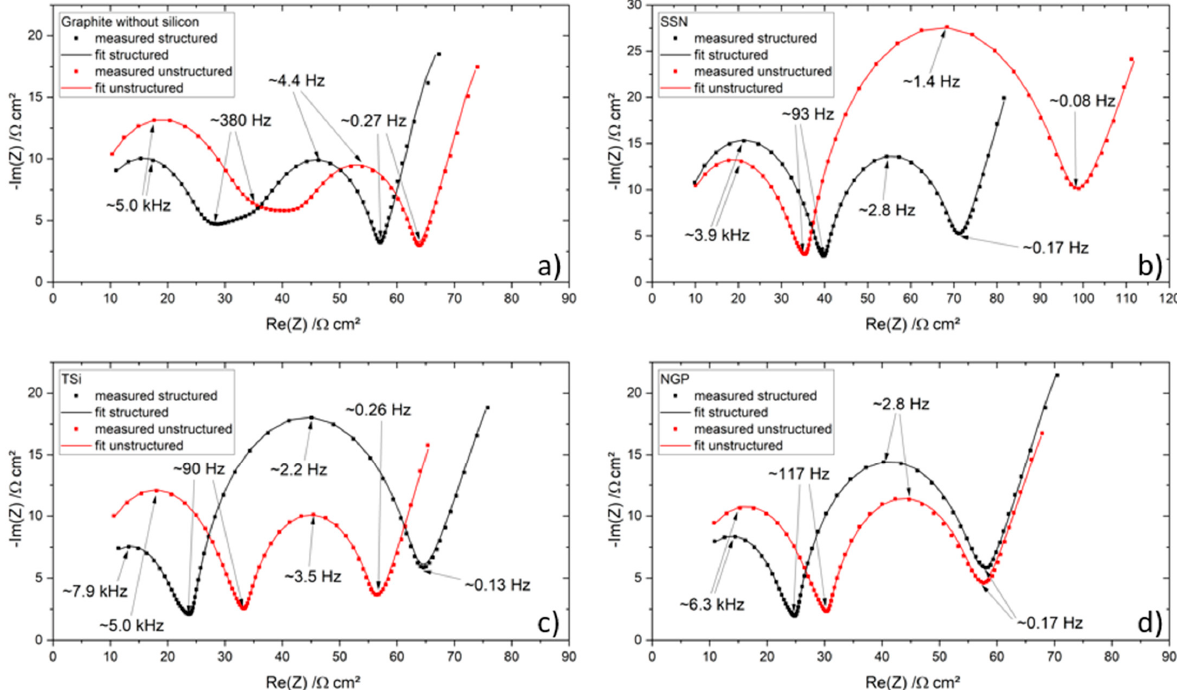
Figure 13. Electrochemical impedance spectra of the pouch cells after the rate capability test and their respective fit: ( a ) graphite, ( b ) SSN, ( c ) TSi, and ( d ) NGP anode.